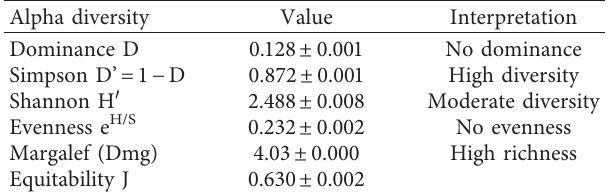
Figure 3: The most abundant genera (including some predominant families) in the gut of A. nigrocincta . Table 1: Alpha diversity of the OTUs in A. nigrocincta gut cal- culated using